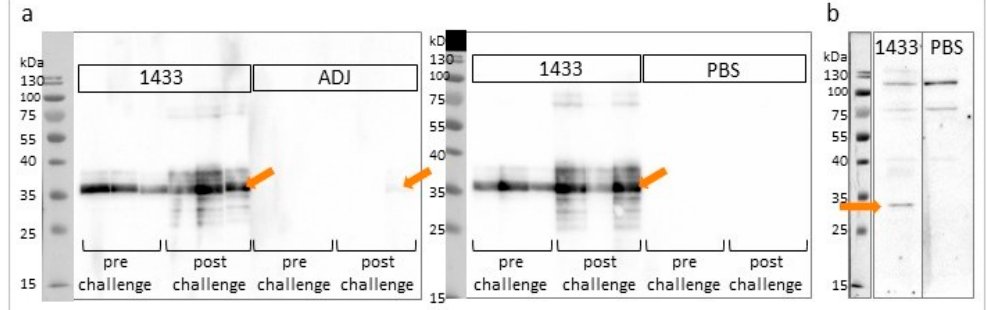
Figure 4. Immunoblot analysis of sera from experimental mice. ( a ) Recombinant Tb14-3-3 (3.8 μ g/lane) detection using mouse sera and secondary anti-mouse IgG antibodies. Experimental groups, named as previously described, and serum collection time (pre or post challenge) are indicated. Specific signals for the 35 kDa band are marked with arrows. ( b ) Native Tb14-3-3 detection using experimental mice sera. T. britovi muscle larvae (ML) somatic protein extract (10 μ g/lane) was incubated with serum from immunized (1433) and control (PBS) mice and secondary anti-mouse IgG antibodies. The specific signal for the 30 kDa band is marked with an arrow.